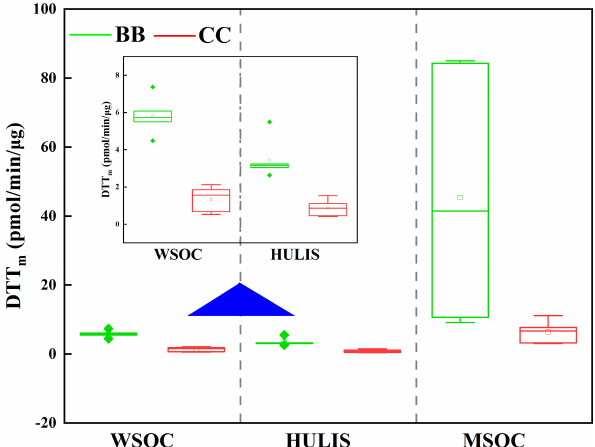
Figure 6. Results of DTT assay conducted on the WSOC, HULIS and MSOC of smoke PM 2 . 5 ; the values were normalized by the mass of smoke PM 2 . 5 . Above the blue triangle symbol is the result coordinates of WSOC and HULIS to be